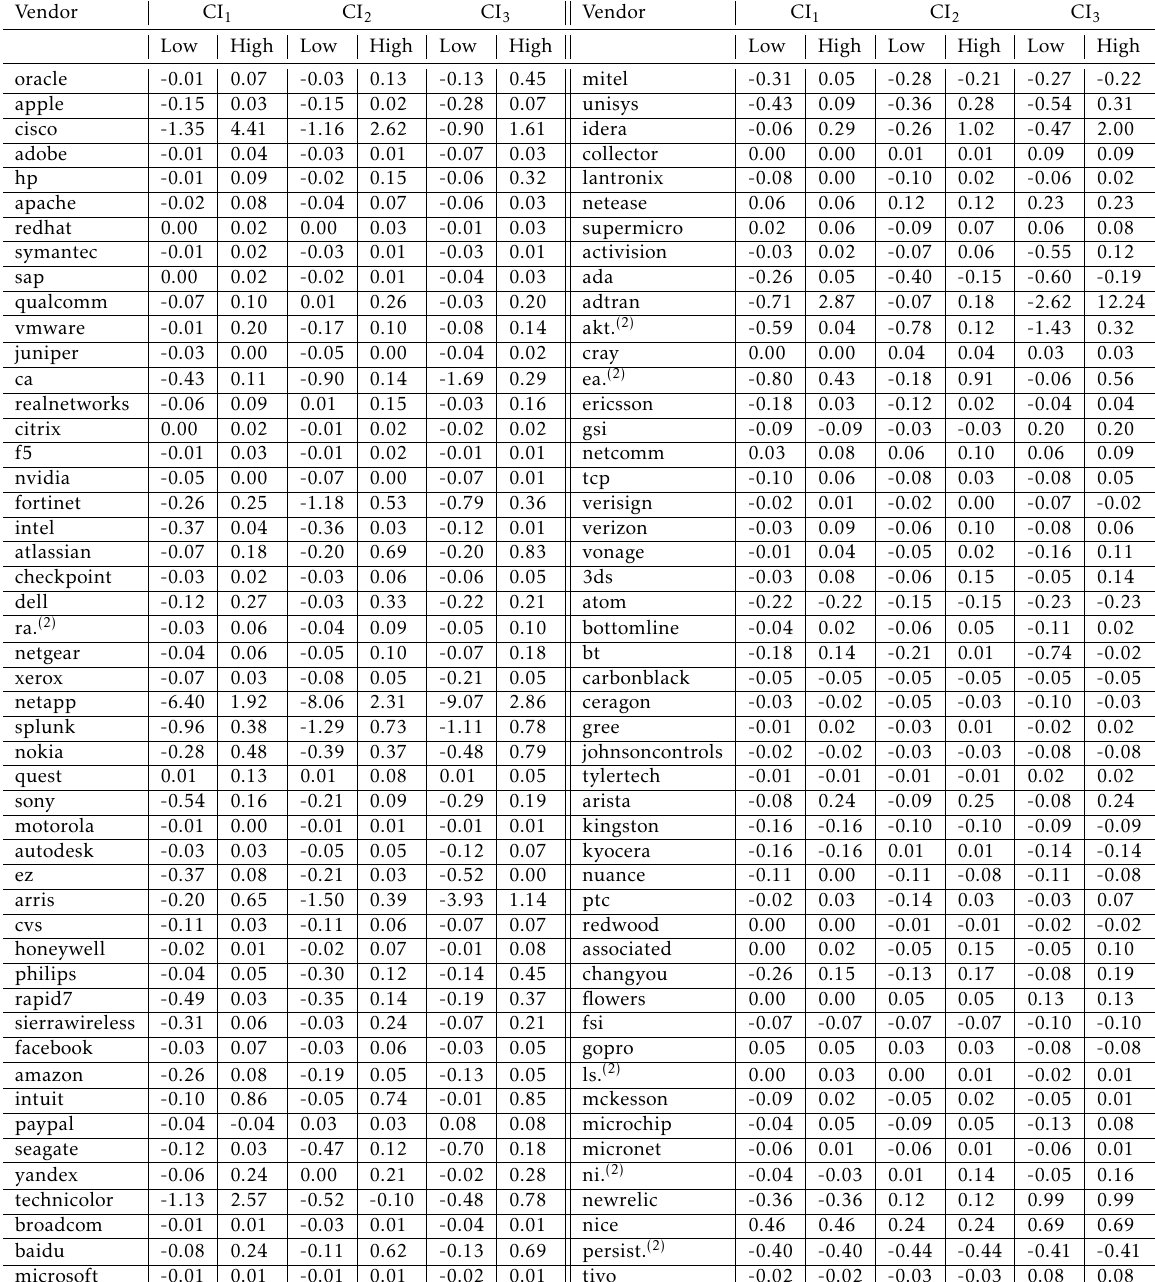
Table 5. Statistical confidence for each Vendor. OAR (percent), respectively. CI i is the confidence interval for day in Table 3 and Table